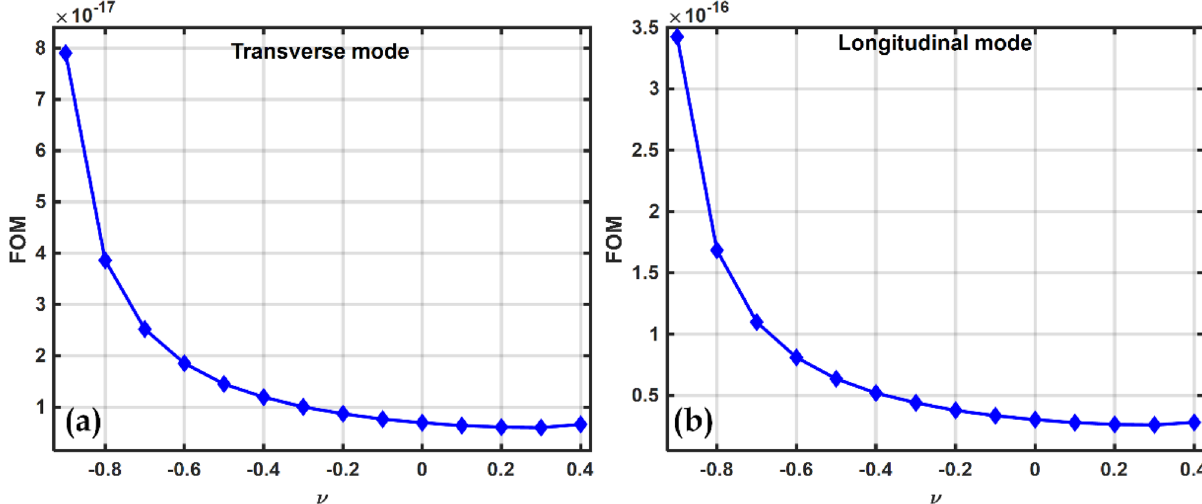
Figure 16. FOM vs ν ( a ) Transverse ( d 31 ) mode and ( b ) Longitudinal ( d 33 ) mode.